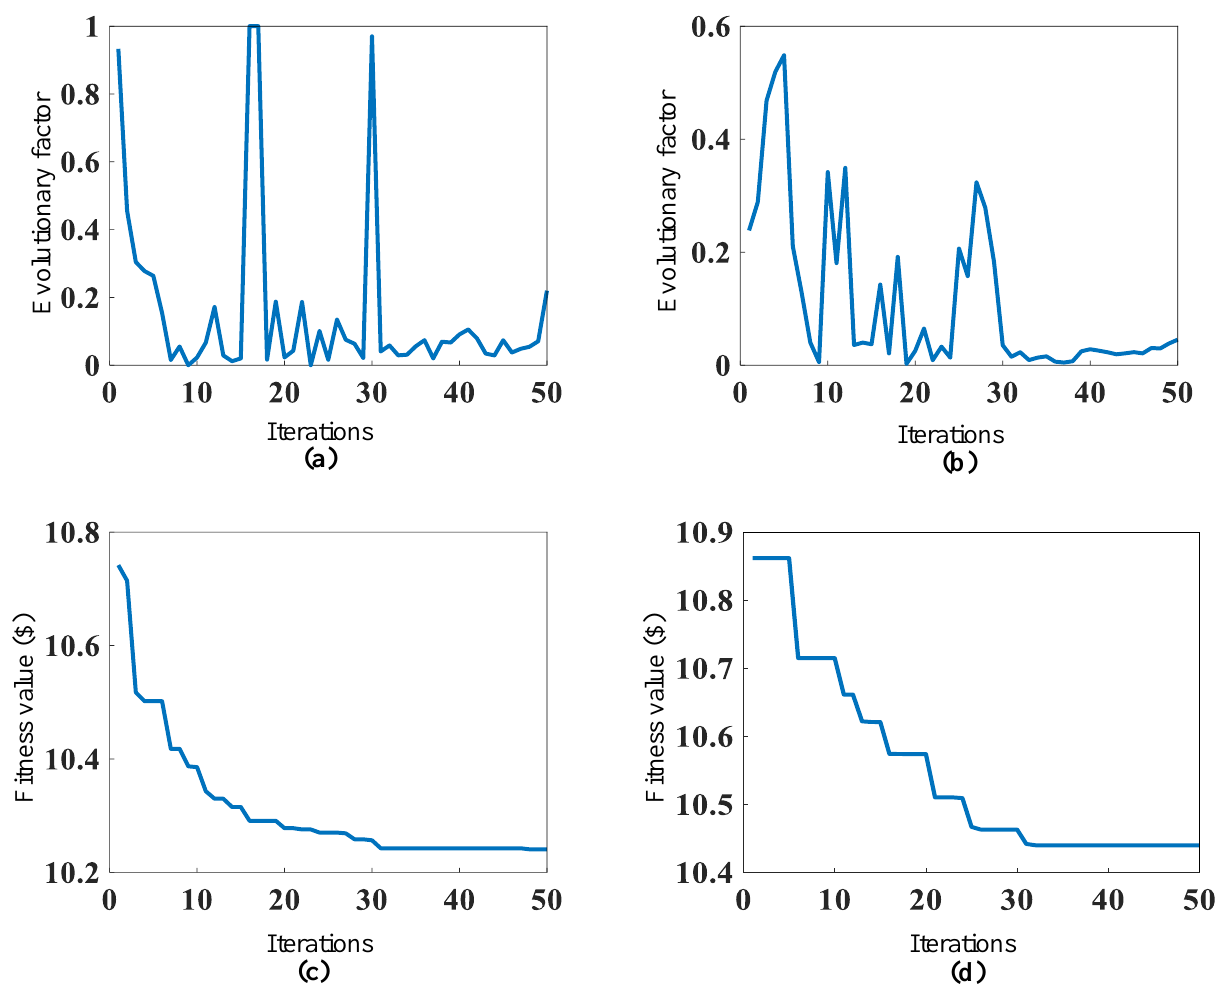
Figure 2. Evolutionary state and fitness in Case 1. ( a ) Evolutionary state in Case 1.1. ( b ) Evolutionary